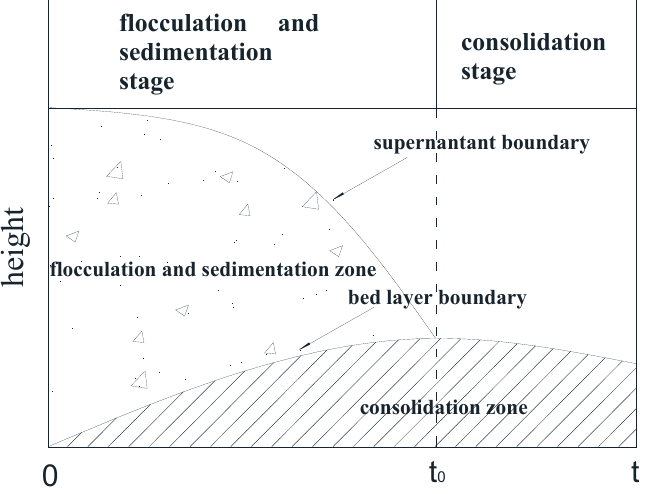
Figure 2. Flocculation and sedimentation of kaolinite particles in the measuring cylinder. Over time, the suspension in the measuring cylinder gradually changed from top to bottom into three layers—the supernatant, the suspension, and the bed layer. With the advance of the deposition process, the intermediate suspension layer gradually disappeared, leaving only the supernatant layer and the bed layer. When the precipitation process reached t = 50,000 min, the observation experiment was terminated.